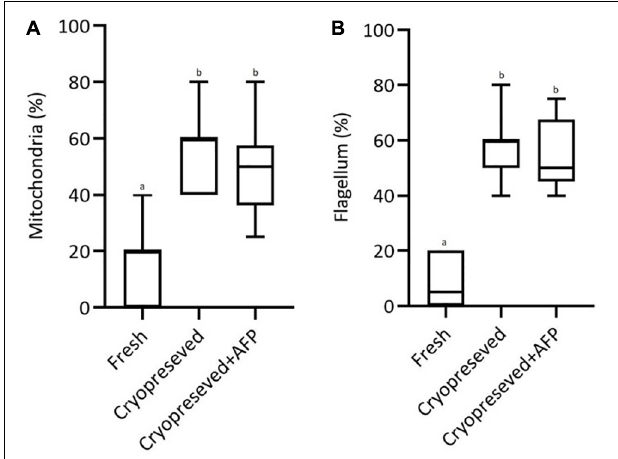
FIGURE 10 | Quantification of morphological alterations in (A) mitochondria and (B) flagellum, comparing fresh, cryopreserved, and cryopreserved spermatozoa with supplementation of 10 µ g/mL AFPI (cryopreserved + AFP). Values with different lower-case letters are significantly different [ p < 0.05, one-way analysis of variance (ANOVA) followed by Tukey’s honest significant difference